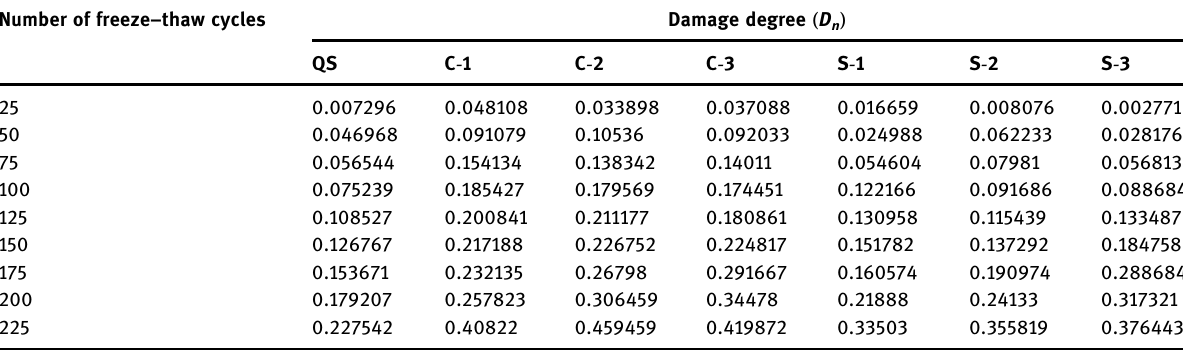
Table 8: Damage degree D n after freezing and thawing cycles Number of freeze – thaw